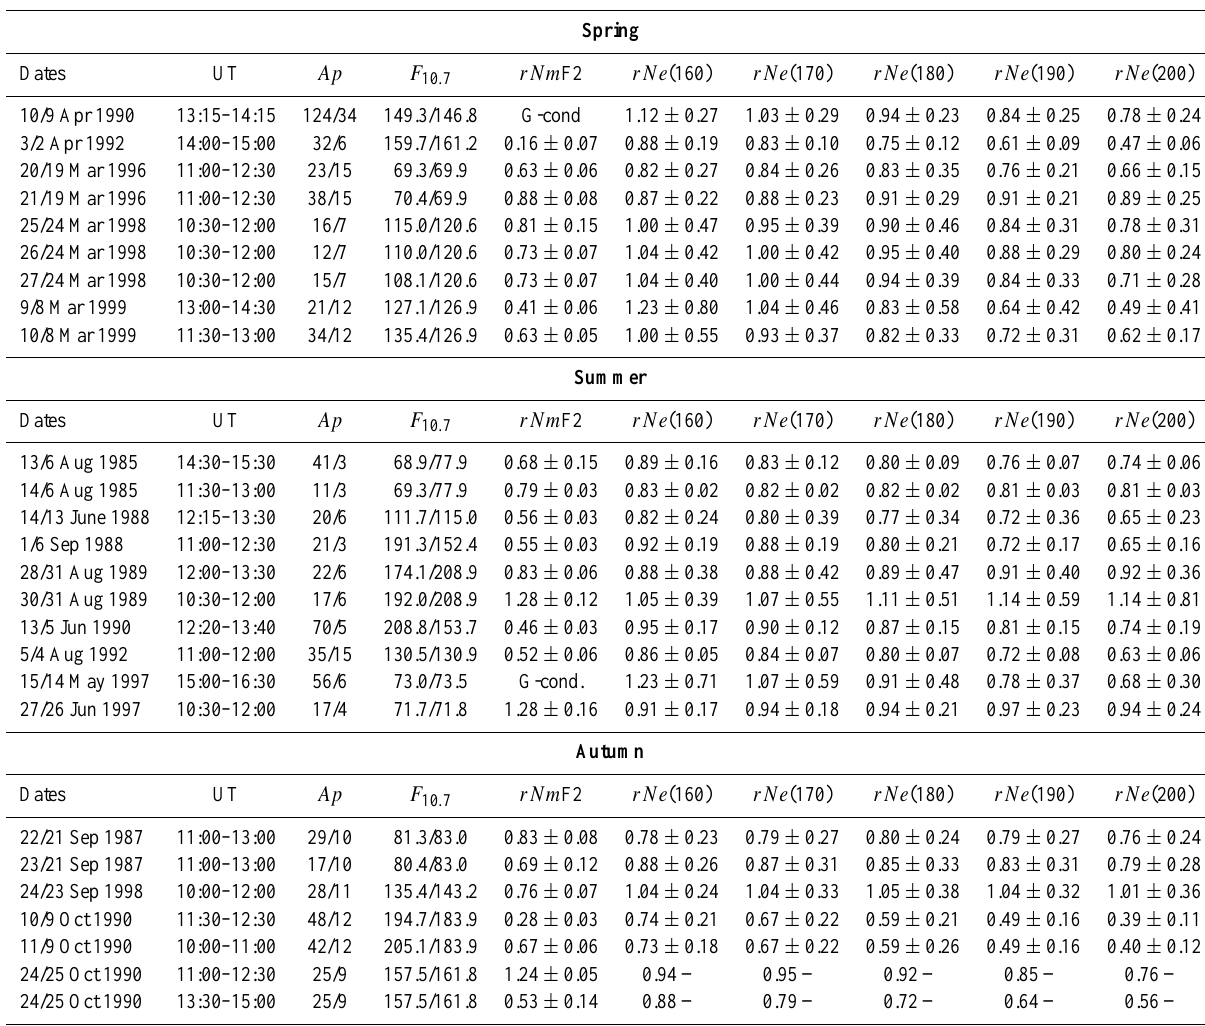
Table 2. List of EISCAT observations (disturbed/reference days), together with daily A p and F 10 . 7 indices. Observed rNm F2 and rNe at 160–200km heights are given, together with absolute deviations (dashes correspond to large scatter in data when calculated standard deviations are unreliable). G-conditions means the absence of the F2-layer peak, LT=UT+1